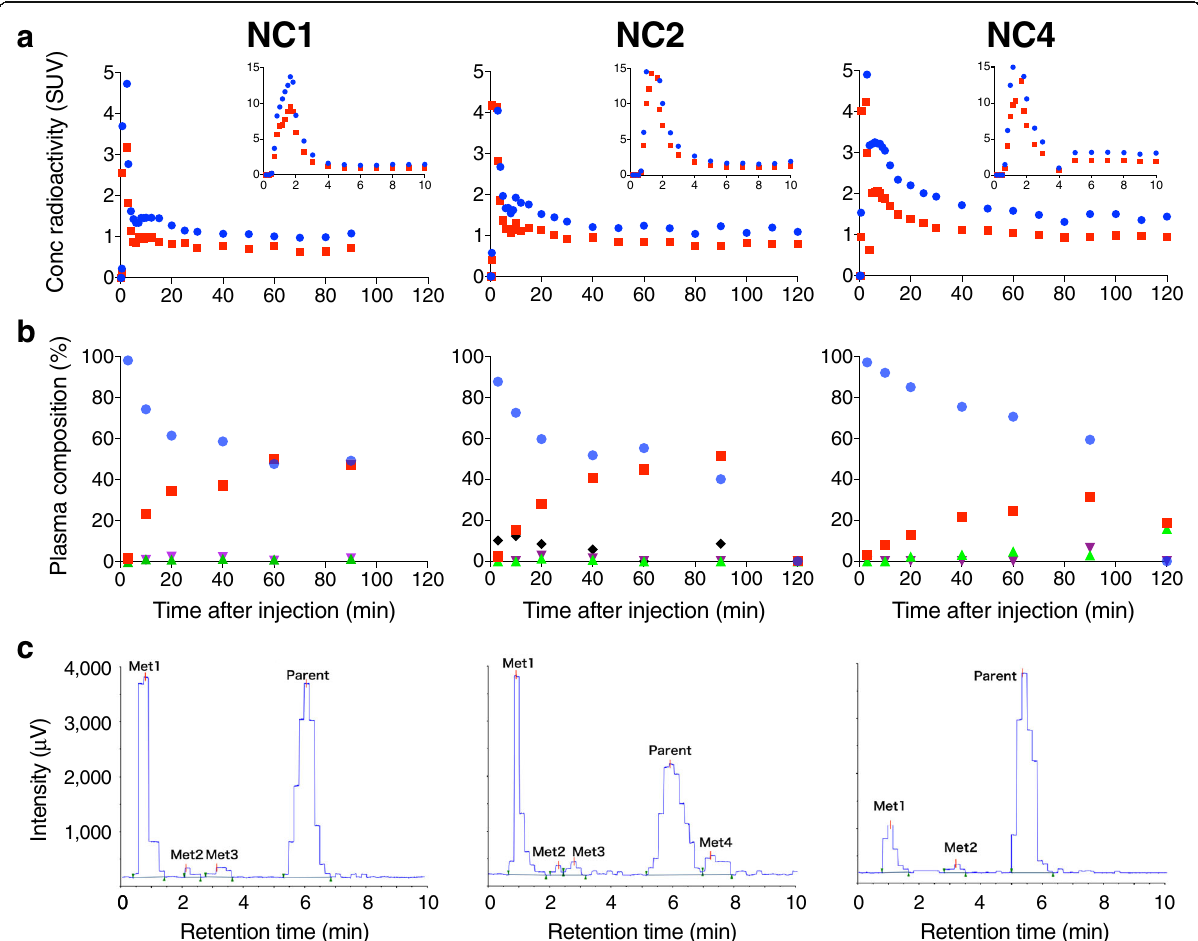
Fig. 1 Concentration of radioactivity and composition of plasma radioactivity in arterial plasma after injection of [ 11 C]HMS011 in three subjects (NC1, NC2, and NC4). a Concentration of radioactivity in plasma ( blue ) and whole blood ( red ). Values from 0 to 10 min and 10 to 120 min are shown in the two graphs with different y -axis ranges. b Composition of parent and radiometabolites in plasma. Parent ( blue ) and radiometabolites (metabolite 1: red , metabolite 2: green , metabolite 3: purple , and metabolite 4: black ) are plotted against time after injection. Note that metabolite 4 was detected only in NC2. c Radiochromatogram of plasma at 20 min (NC1 and NC2) and 60 min (NC4) after injection of [ 11 C]HMS011. Two or three hydrophilic radiometabolites (metabolites 1 – 3) were detected in all subjects. A lipophilic radiometabolite (Met4) was detected only in